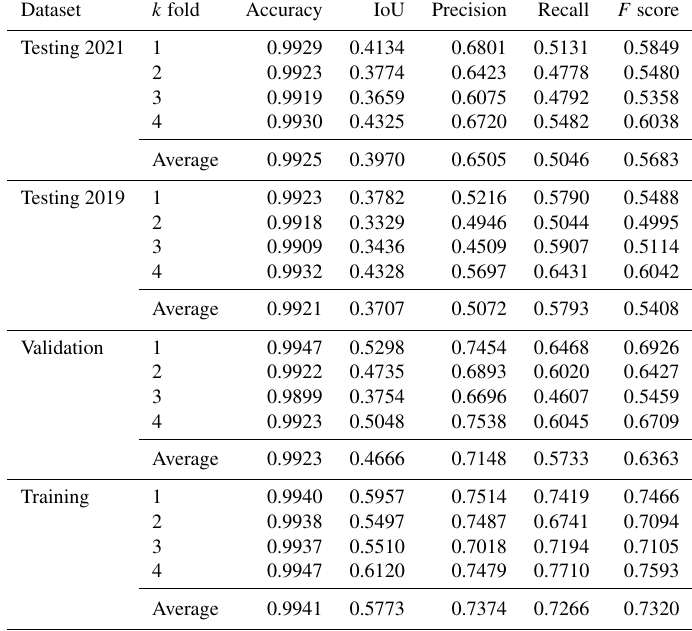
Table A4. Full performance metrics for the green roof identification method, calculated based on